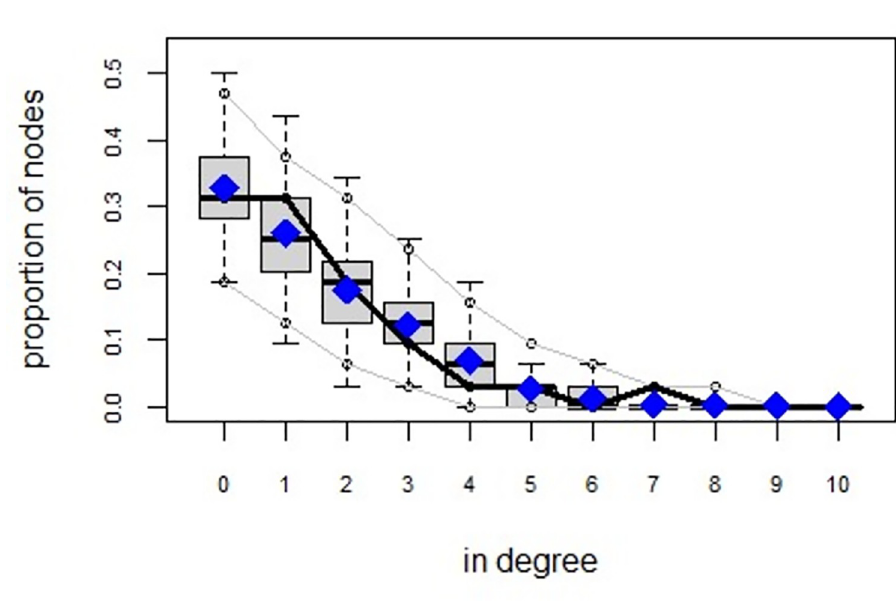
Fig 8. Multiplexity in the alpha community—goodness of fit [24] in degree.